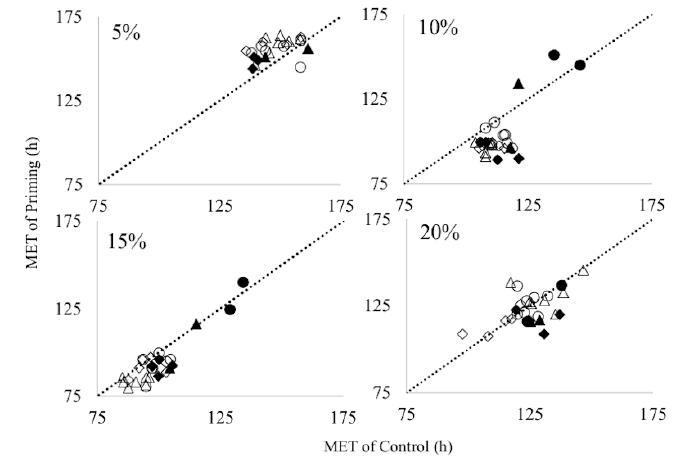
Figure 2. Relationship between control and priming of mean emergence time (MET) in the four soil moisture conditions. The dotted line indicates position of the x value equal to y value. Each plot shows one condition. Black circles, black rhombuses, white circles, white rhombus, black triangles and white triangles indicate genotype group1, 2, 3, 4, 5 and 6, respectively. Genotype groups are determined by cluster analysis (illustrated in Figure 2). Table 5. Correlation coefficients (r) of control and priming of the time to achieve 50% plant emergence (E50), mean plant emergence time (MET), plant emergence uniformity (EU), plant height (PH), and plant height uniformity (PHU) under four soil moisture conditions.